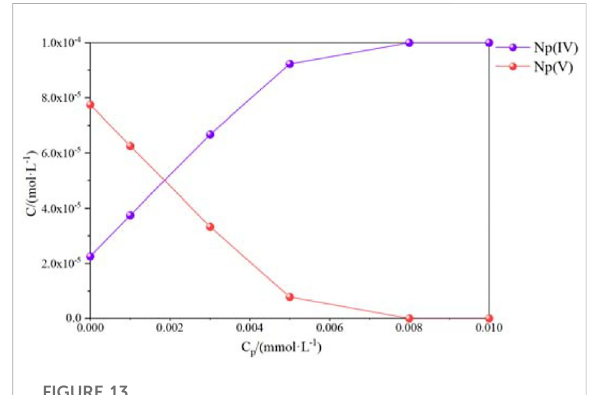
FIGURE 13 Concentration of Np( Ⅳ )and Np( Ⅴ ) as a function of the pyrite concentration.